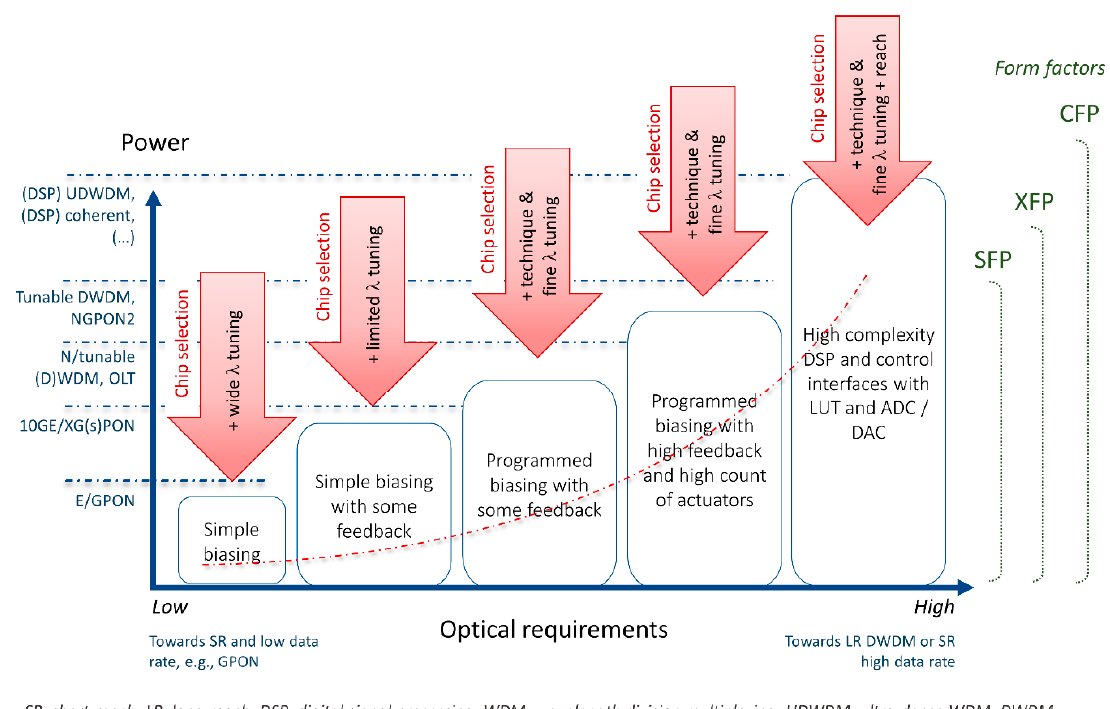
Figure 8. Diagram of requirements in terms of control, complexity, and power for di ff erent technologies.